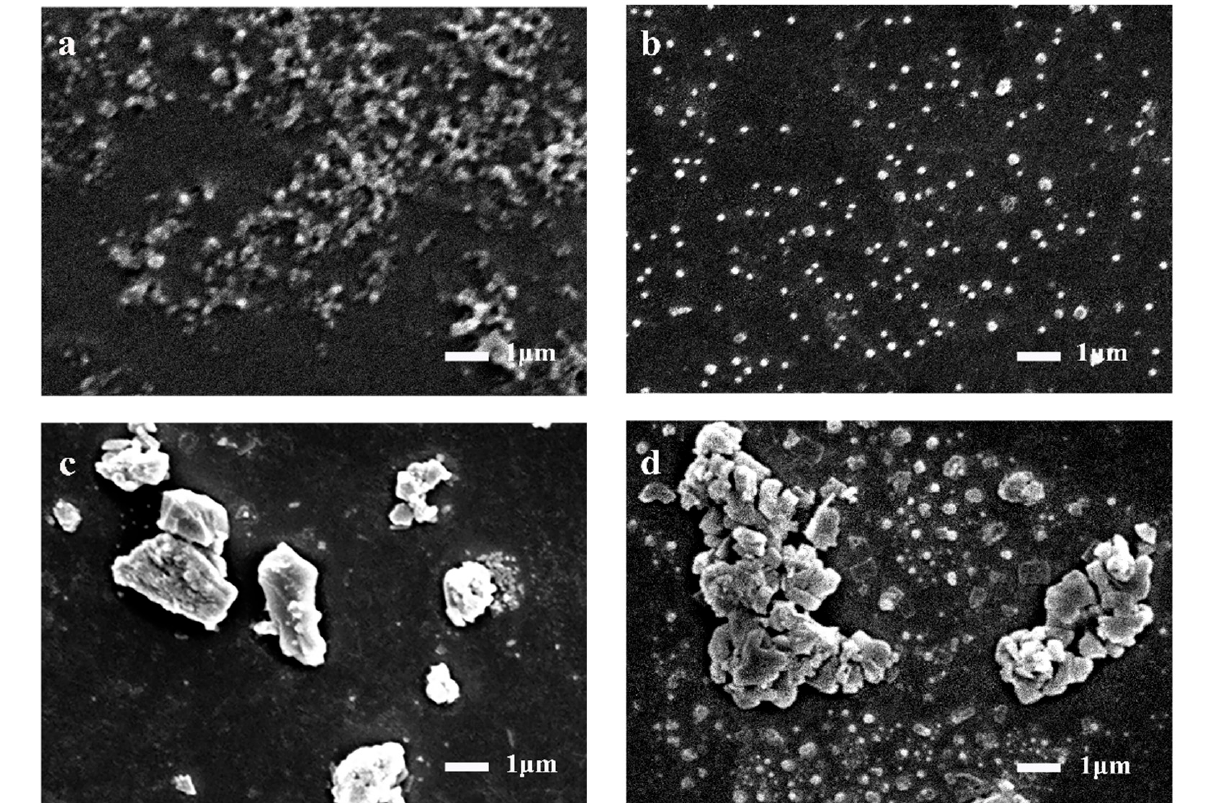
Figure 2. SEM of polyaniline under different polymerization times: ( a ) 4 h; ( b ) 8 h; ( c ) 12 h; ( d ) 16 h. The electrodes with different polymerization times were coated on graphite paper and named PANI-4, 8, 12, 16. Figure 3a shows the CV curve of polyaniline electrode with polymerization time. It can be seen from the image that the electrode with PANI-8 has the largest integral area. According to Nyquist curve (Figure 3b), the EIS curve of PAIN-8 has the smallest intercept with the X -axis, while the intercept of PANI-12 and PANI-16 is larger, which is due to the low equivalent series resistance caused by their stacked structure. Compared with other curves, the PANI-8 curve has a steeper slope, indicating that its ionic diffusion impedance is lower and it has better electrochemical performance. This corresponds to the micromorphological phenomena observed by the electron microscope. Figure 3c shows that the redox peak of the polyaniline electrode appears at 0.3 V. With the increase in scanning rate, the redox peak of the polyaniline electrode shifts to high potential, and its curve shape changes regularly, which shows that it has good discharge performance. Combined with previous work, a polyaniline electrode with excellent electrochemical properties was successfully synthesized according to the discharge law of polyaniline. In Figure 3d, an obvious discharge plateau appears at 0.3 V, which is completely consistent with the CV curve. The existence of the discharge platform proves that polyaniline undergoes a redox reaction during charging and discharging. In this process, charge transfer occurs between interfaces, which greatly increases the discharge time of the capacitor